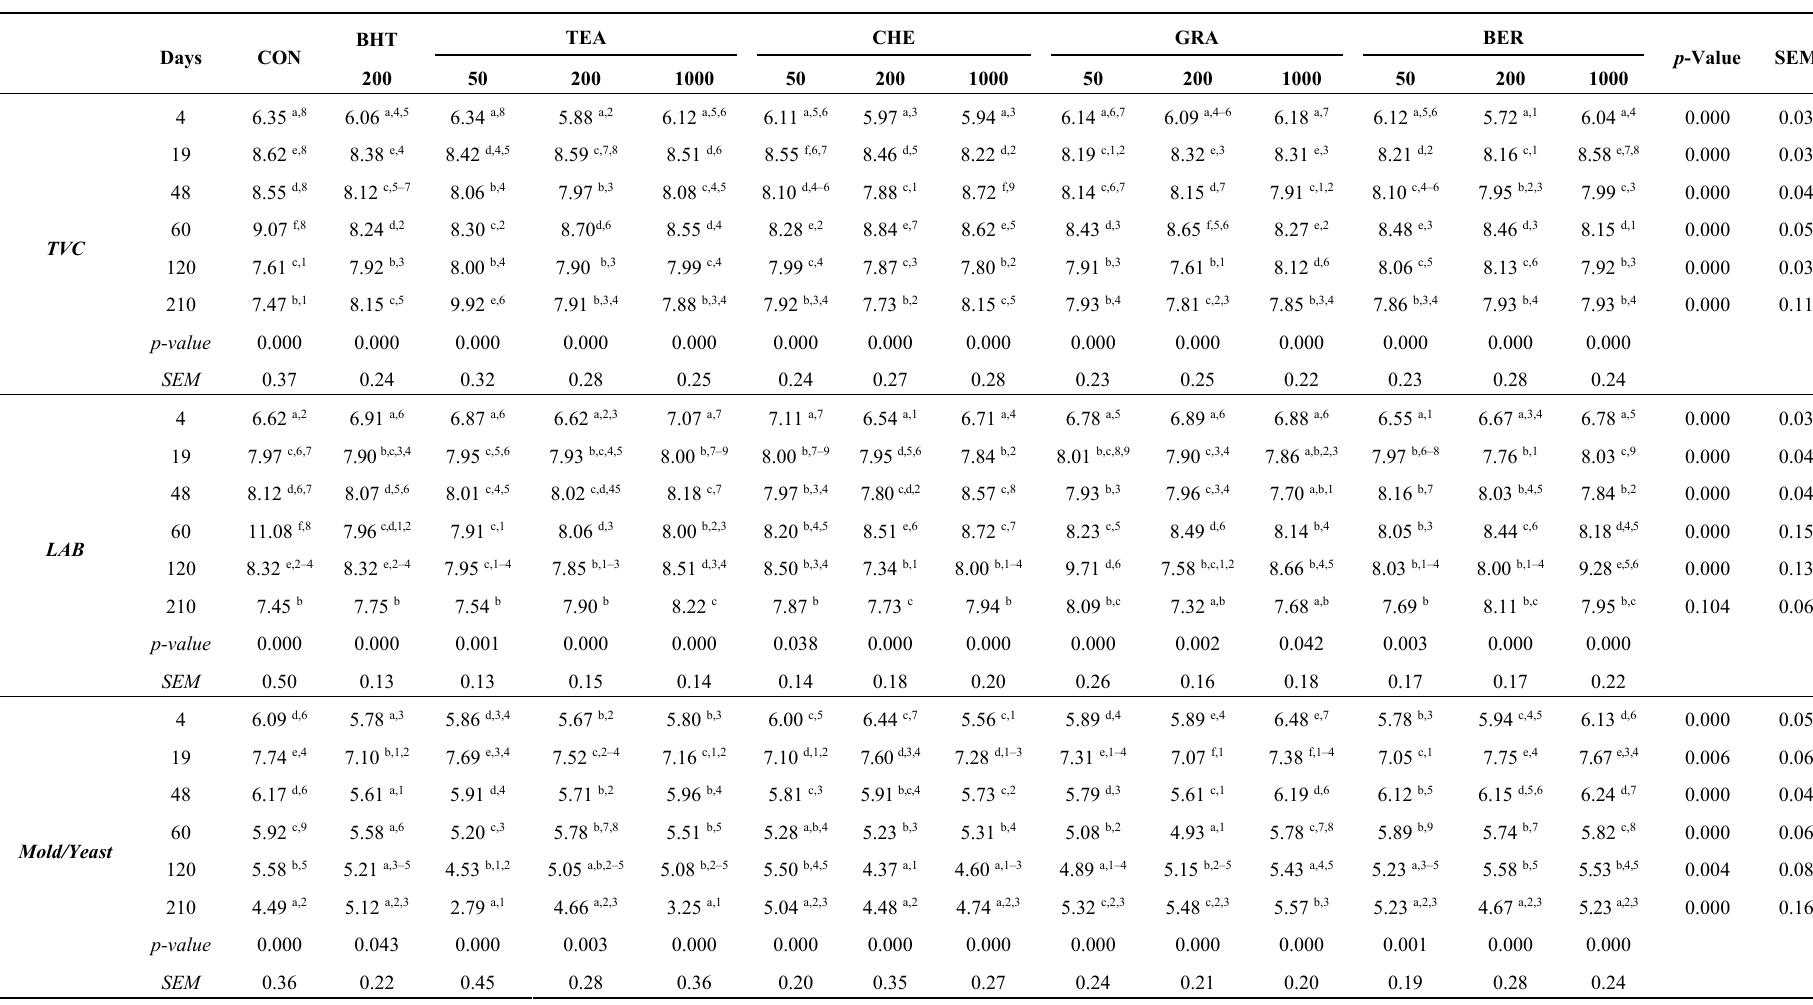
Table 3. Evolution of TVC, BAL and mold/yeast of “chorizo” treated with BHT and natural antioxidants during ripening and